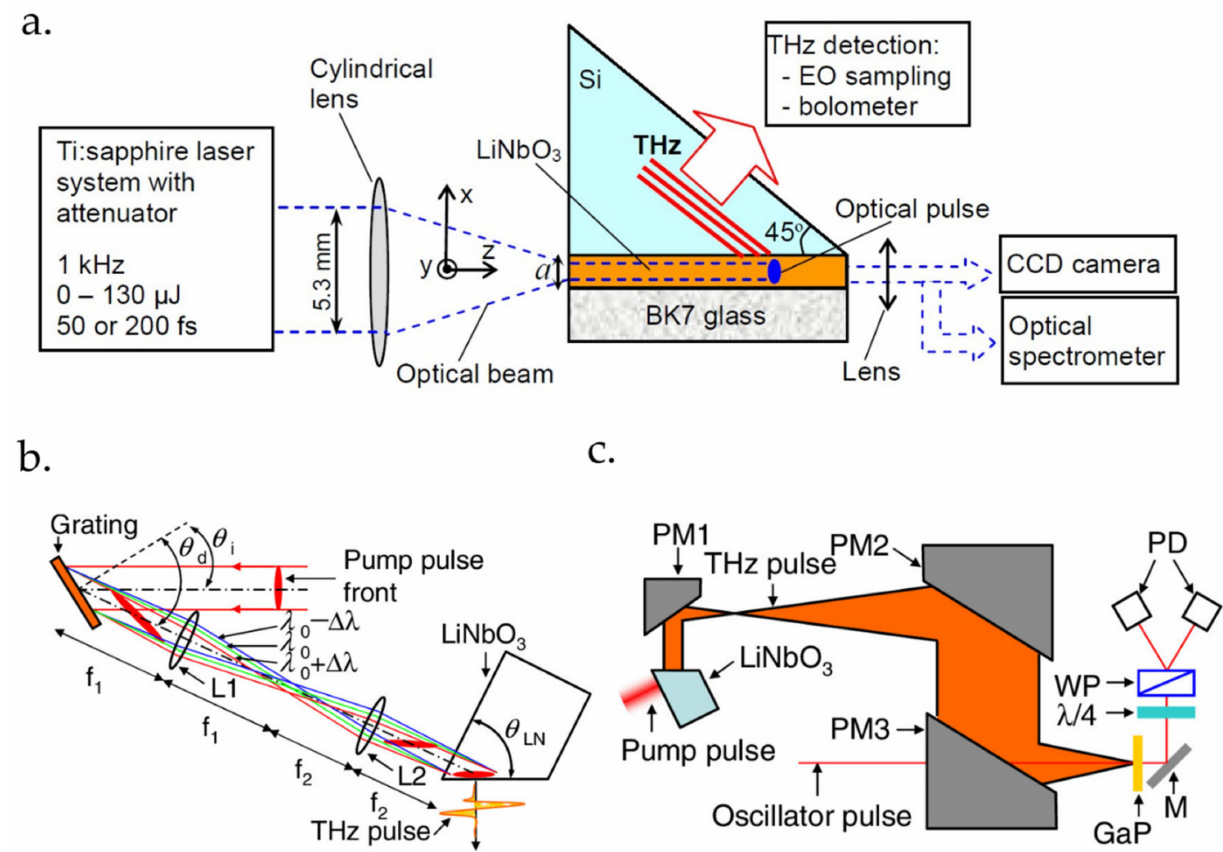
Figure 3. Cherenkov geometry and TPF. ( a ) The point focus beam radiates THz with Cherenkov angle θ c , and the generated THz symmetrically forms a cone. ( b ) A side view for line focus. The THz radiates to two sides to form a wedge. ( c ) A top view of THz generation in the TPF technique, the THz wave radiates along with the propagation of the pump pulse front on one